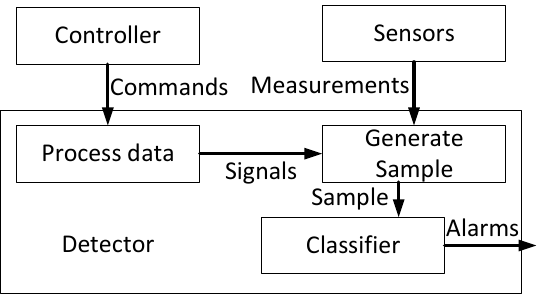
Figure 2. The structure of the Heterogeneous Data Learning Detector